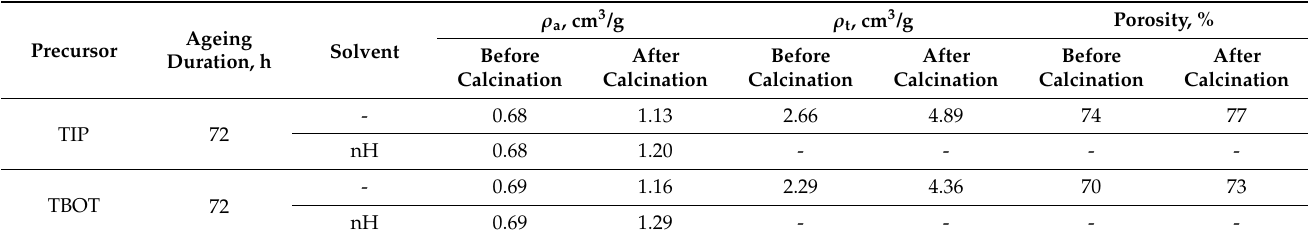
Table 4. TiO 2 aerogel density and porosity in relation to the synthesis conditions.